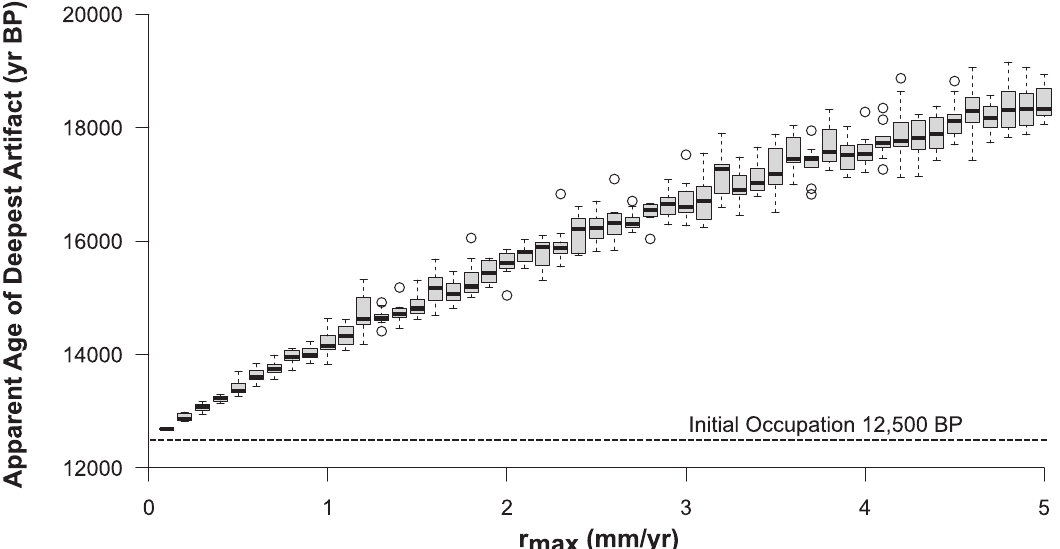
Fig 2. The relationship between simulated rates of artifact dispersal (r max ) and the apparent age of the deepest artifact. Dashed line shows the age of the initial occupation at 12,500 BP.